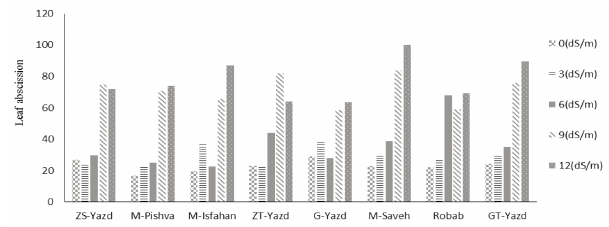
Fig. 4 ­ The interaction effects of salinity levels and cultivars on leaf abscission.